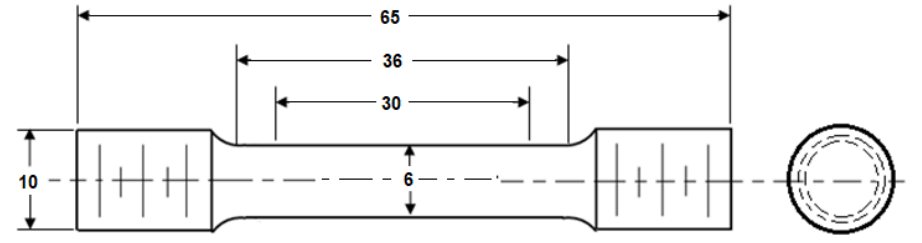
Figure 1. Tensile test specimen. All dimensions are in mm.